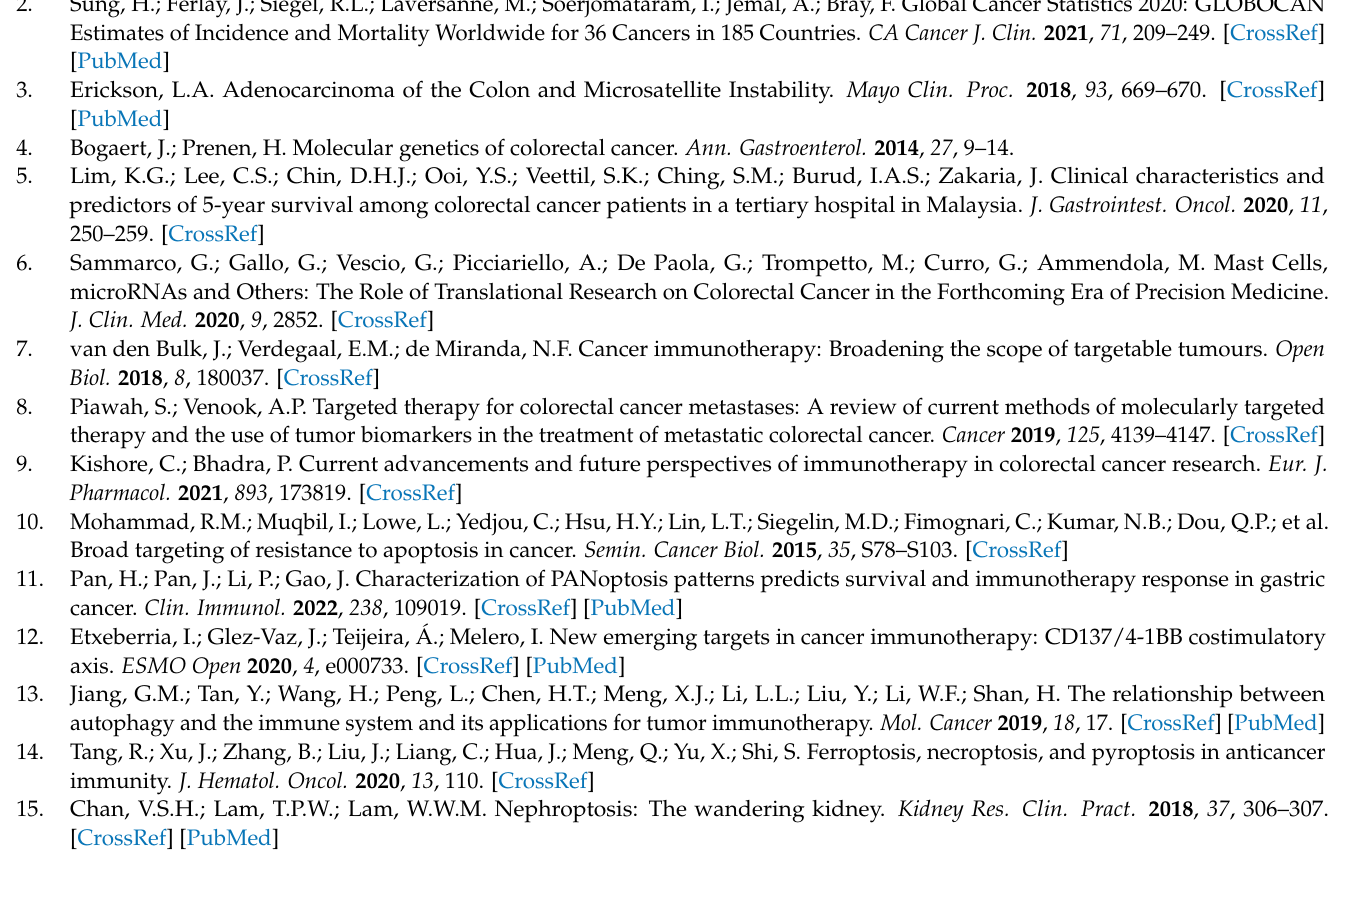
Table S3: The list of 421 necroptosis-related differentially expressed lncRNAs. Table S4: The results of gene-set enrichment analysis (GSEA). Supplementary Information S1: Supplementary Information about the Methods of In Vitro/in vivo